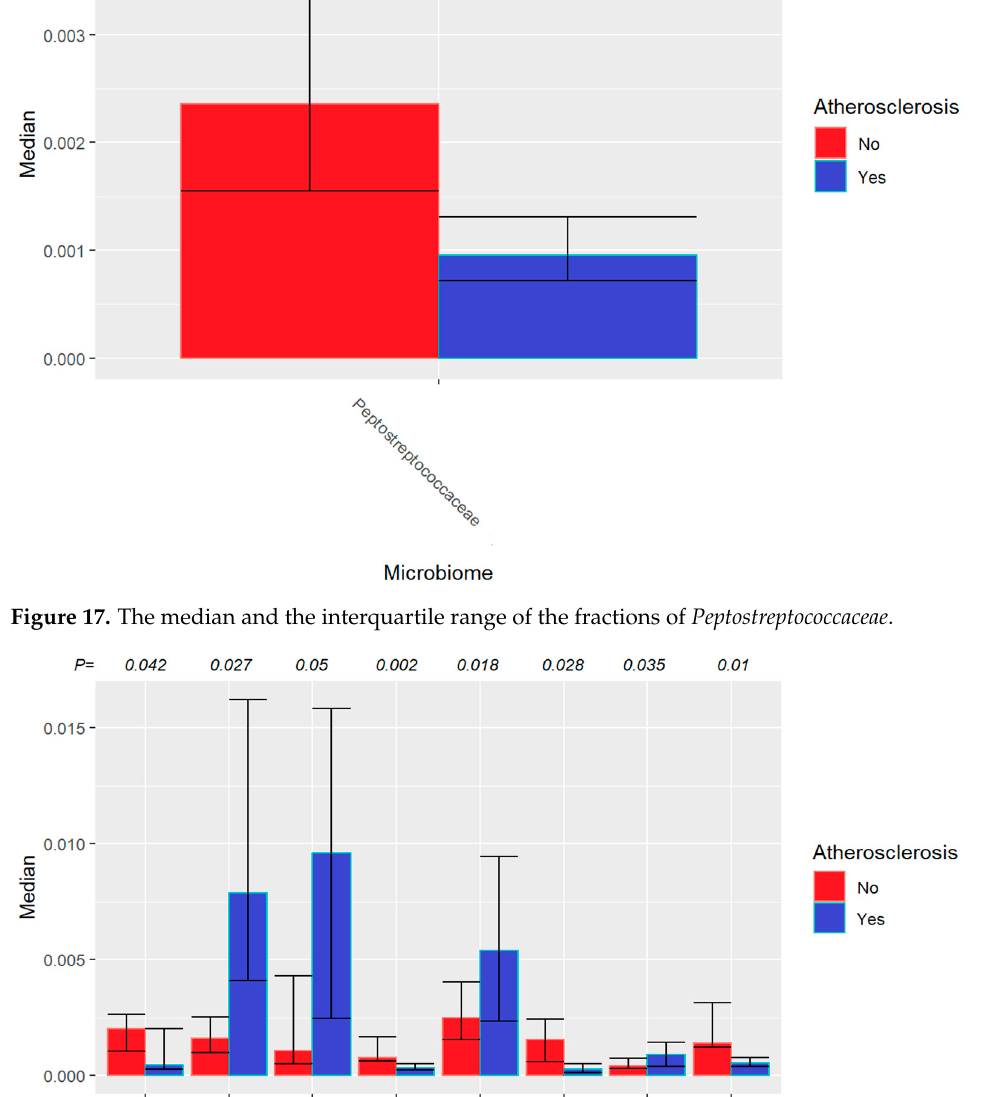
Figure 18. The candidate microbes at the genus taxonomic level without correction in the two groups.